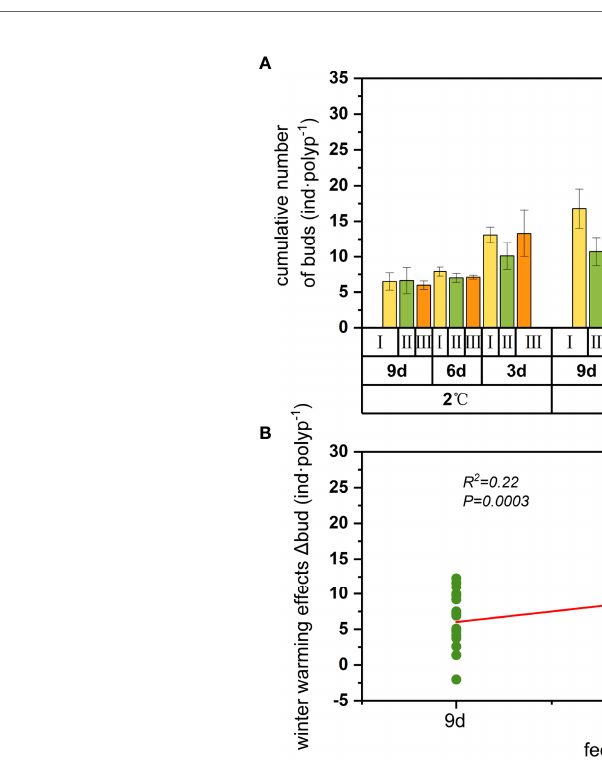
FIGURE 7 | Cumulative numbers of buds released per polyp in 27 treatments (A) and relationship of winter warming effects on cumulative number of buds produced per polyp at different feeding frequencies (B)